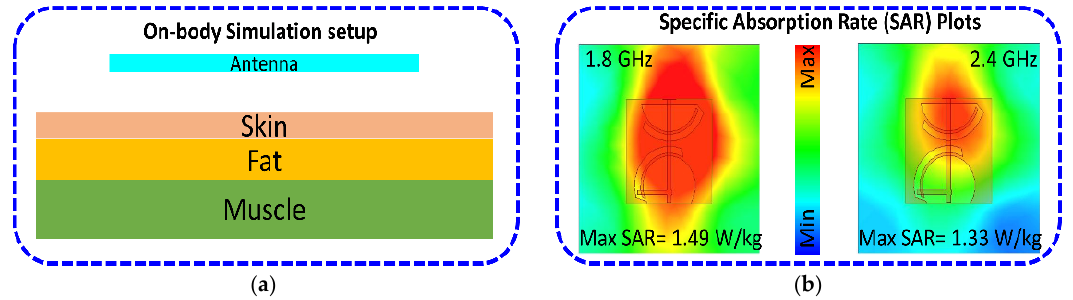
Figure 14. On-body analysis of the proposed antenna: ( a ) simulation setup for on-body analysis ( b ) 10-g SAR distributions at 1.8 and 2.4 GHz.